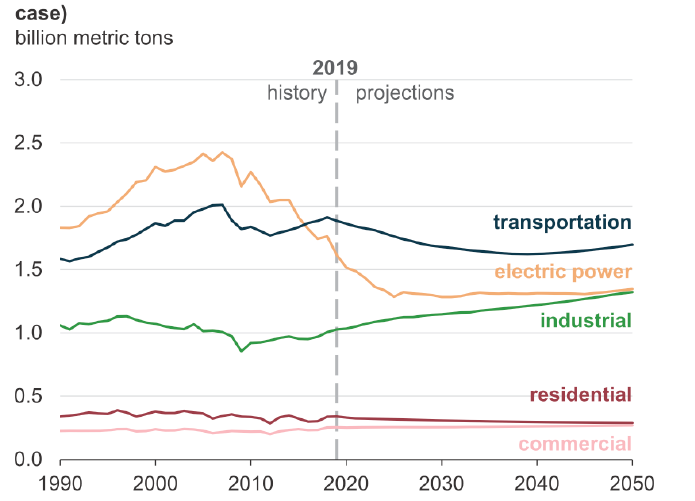
Figure 4. Energy-related CO 2 emissions by the energy sector [4].